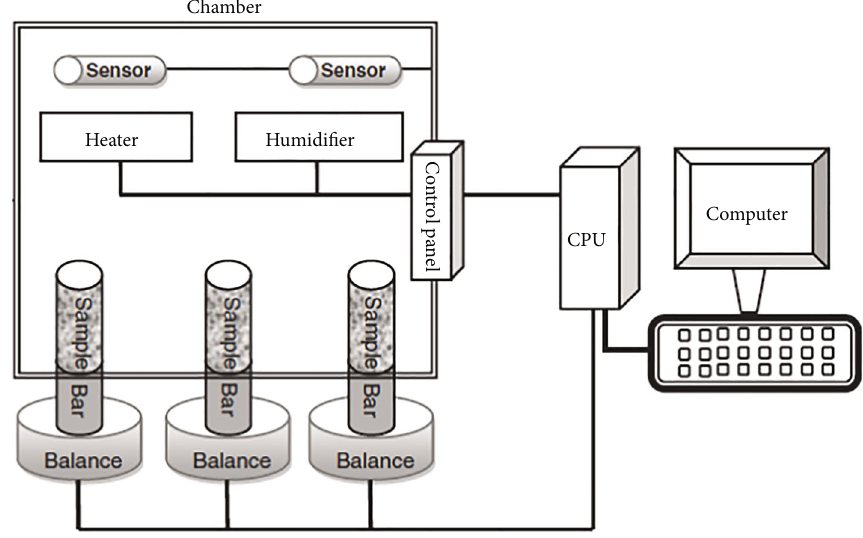
Figure 2: Schematic diagram of the experimental system for water vapor sorption of deep soft rocks